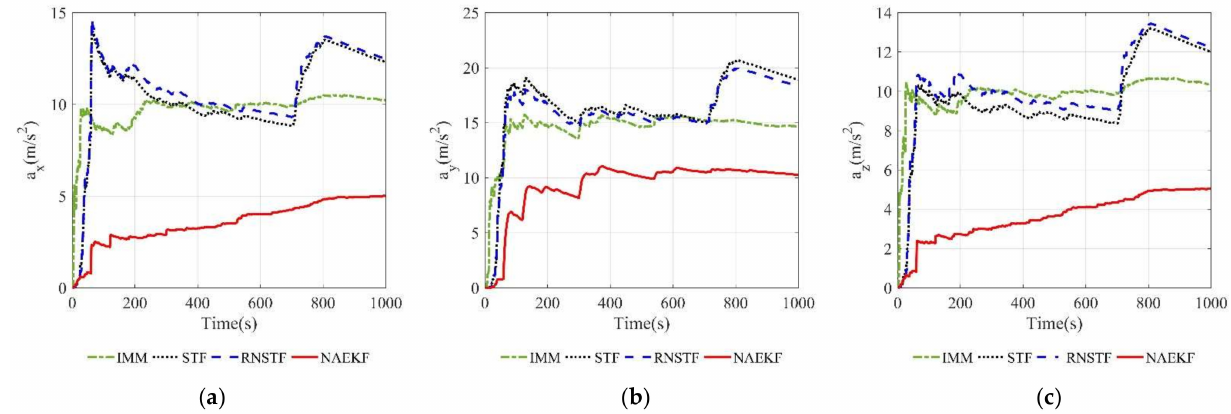
Figure 24. σ -Boundary of acceleration estimation errors. ( a ) σ -Boundary of a x ; ( b ) σ -Boundary of a y ; ( c ) σ -Boundary of a z